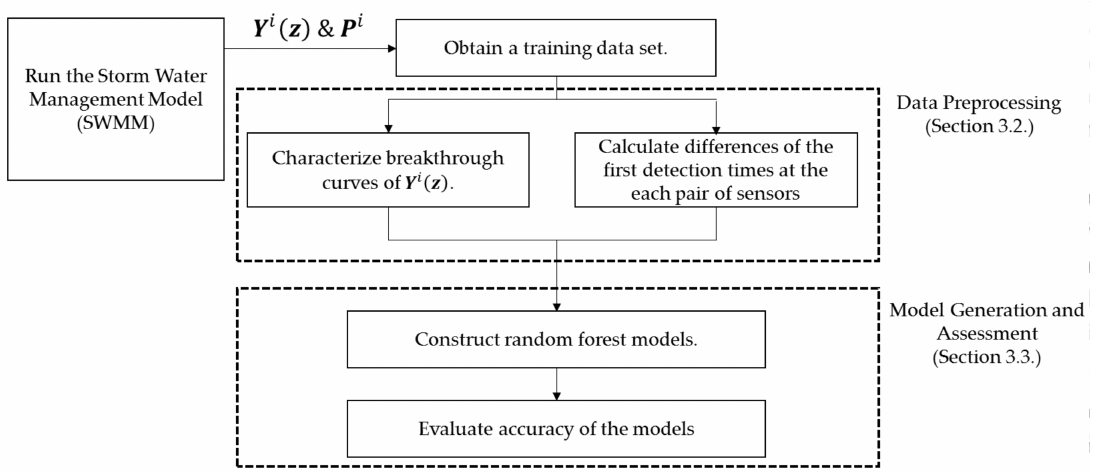
Figure 2. Workflow of the proposed